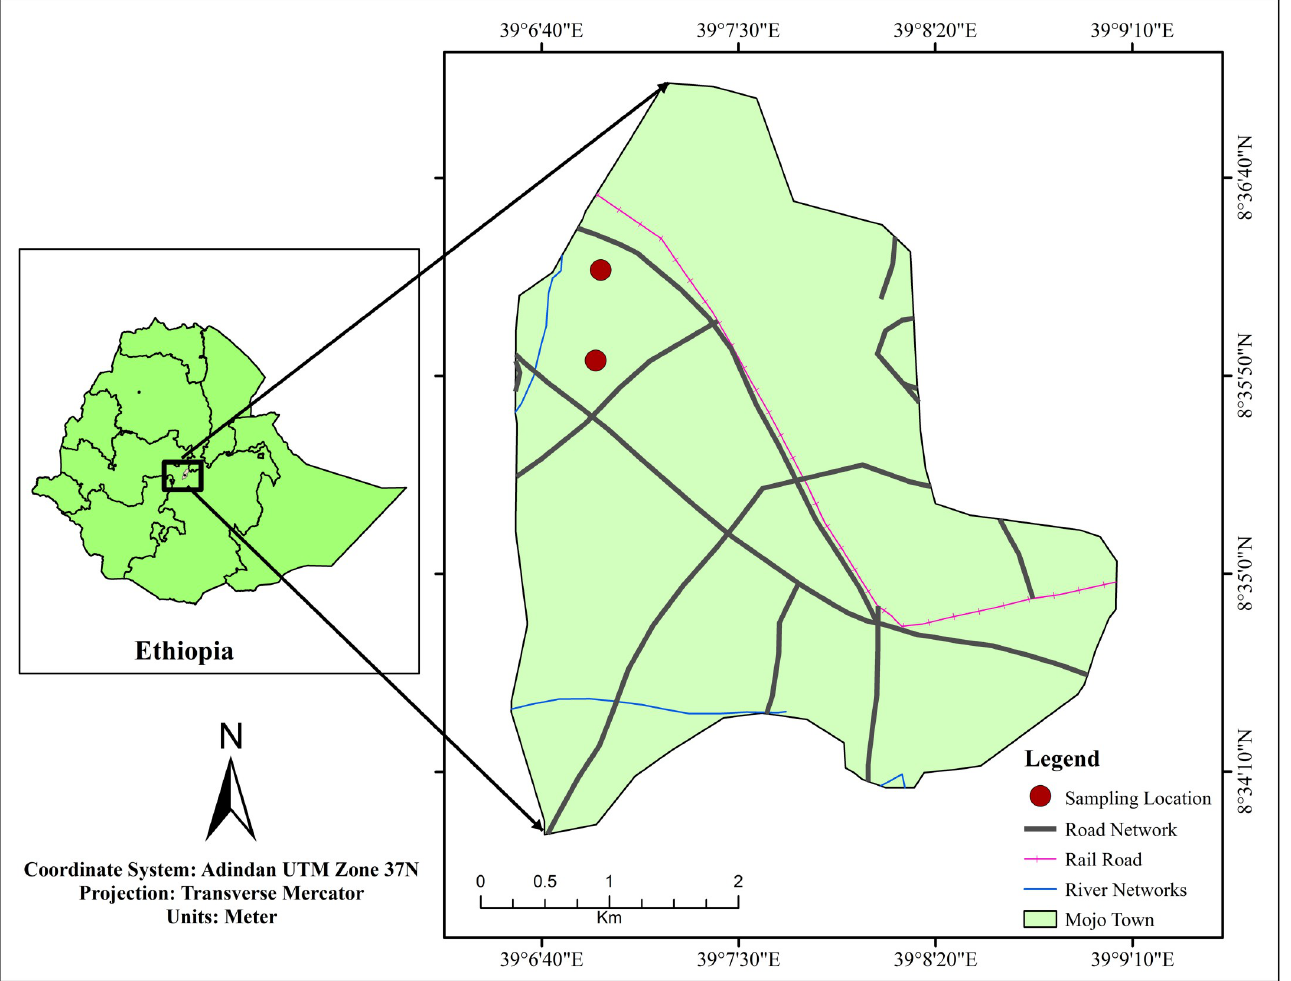
Fig 1. Location map of the study area (drawn by ArcGIS 10.3 software). https://doi.org/10.1371/journal.pone.0227883.g001 PLOS ONE | https://doi.org/10.1371/journal.pone.0227883 January 30,